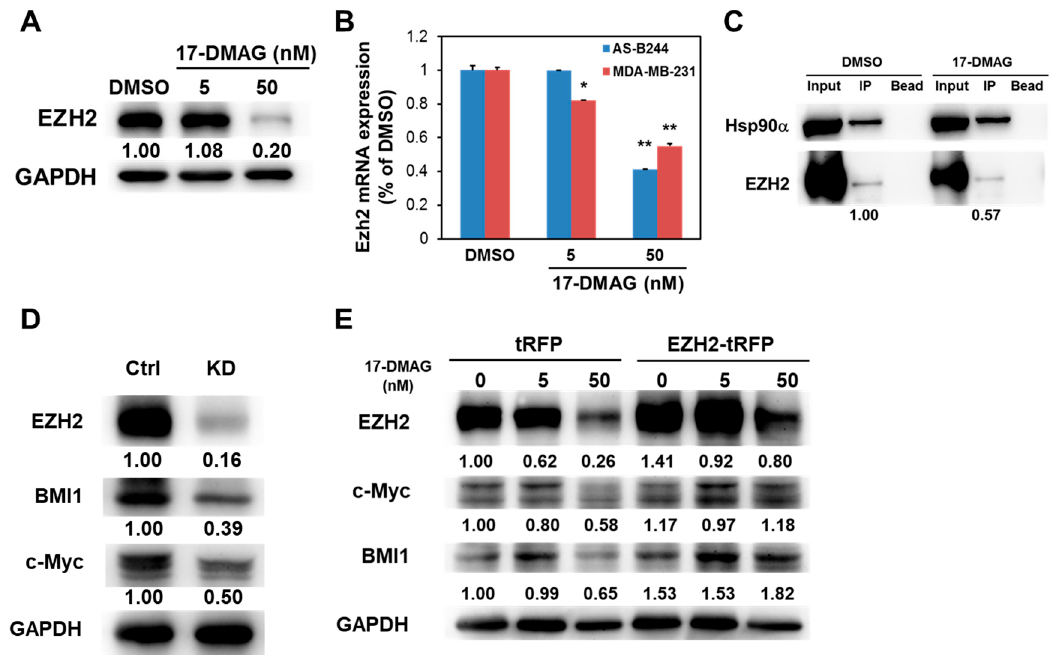
Figure 4. EZH2 expression in MDA-MB-231 mammospheres was suppressed by 17-DMAG. ( A , B ) The protein ( A ) or mRNA ( B ) expression of EZH2 in MDA-MB-231 mammospheres after 17-DMAG treatment (5 or 50 nM) was determined at 96 h ( A ) or 48 h ( B ). * p < 0.05; ** p < 0.01. ( C ) The interaction between EZH2 and Hsp90 α in mammospheres of MDA-MB-231 after 17-DMAG treatment (50 nM) was determined by immunoprecipitation with anti-Hsp90 α antibody; ( D ) Knockdown of EZH2 in primary mammosphere from MDA-MB-231 cells was performed by lentiviral delivery of LacZ- (Ctrl) or EZH2- (KD) specific shRNAs and total proteins were extracted for determination of EZH2, BMI1 or c-Myc expression by Western blot; ( E ) Overexpression of EZH2 was performed by lentiviral delivery of tRFP or EZH2 gene into MDA-MB-231 cells and selected by 20 µg/mL BSD for five days. Successfully-transduced cells were then cultured into mammosphere, treated with 0.1% DMSO or 17-DMAG (5 or 50 nM) for 96 h, and extracted the total proteins for determination of BMI1, c-Myc, EZH2, or GAPDH expression by Western blot. Inserted numbers indicated relative protein expression levels in comparison with the control.